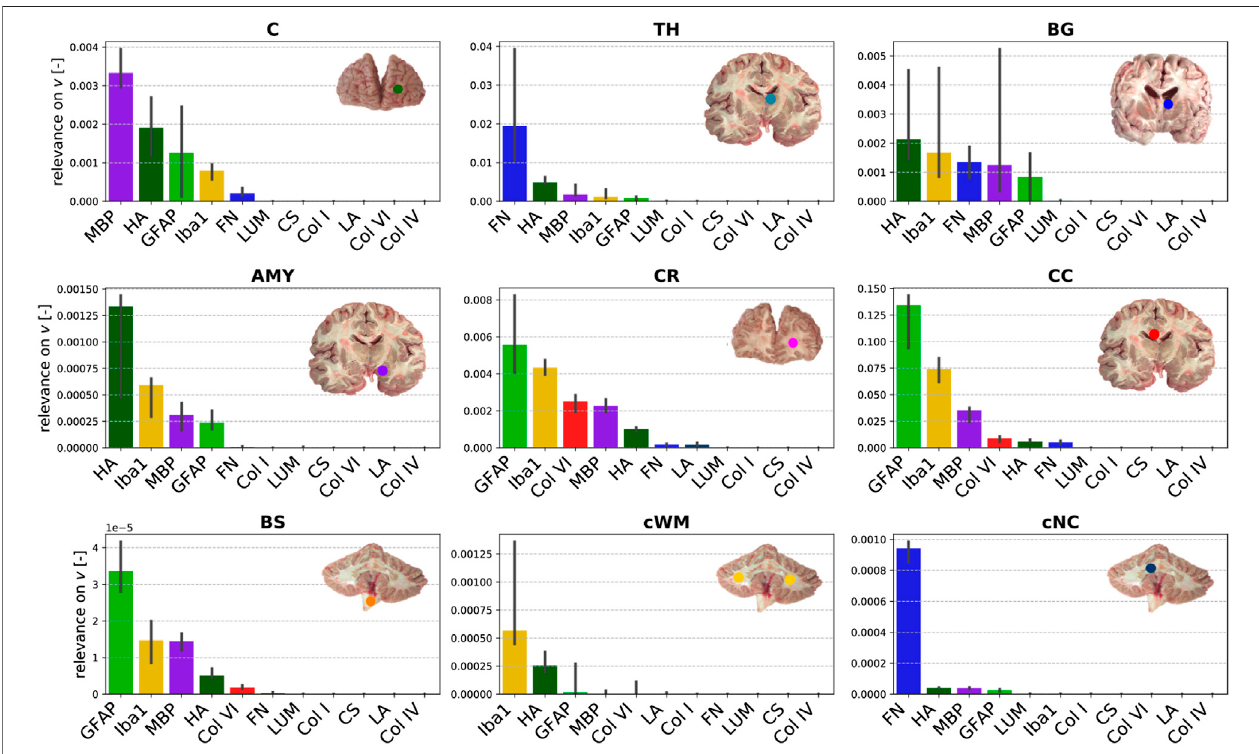
FIGURE 10 | Relevance of the ELISA (see Table 3 ) values for the Prony series parameters in different brain regions (see Table 2 ).